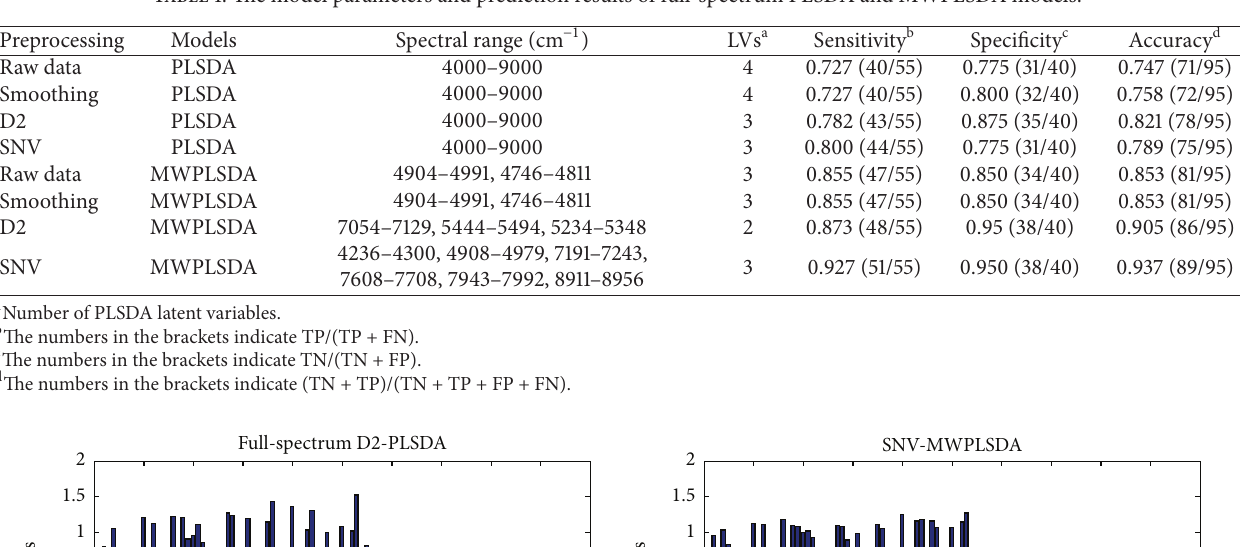
Table 1: The model parameters and prediction results of full-spectrum PLSDA and MWPLSDA models.